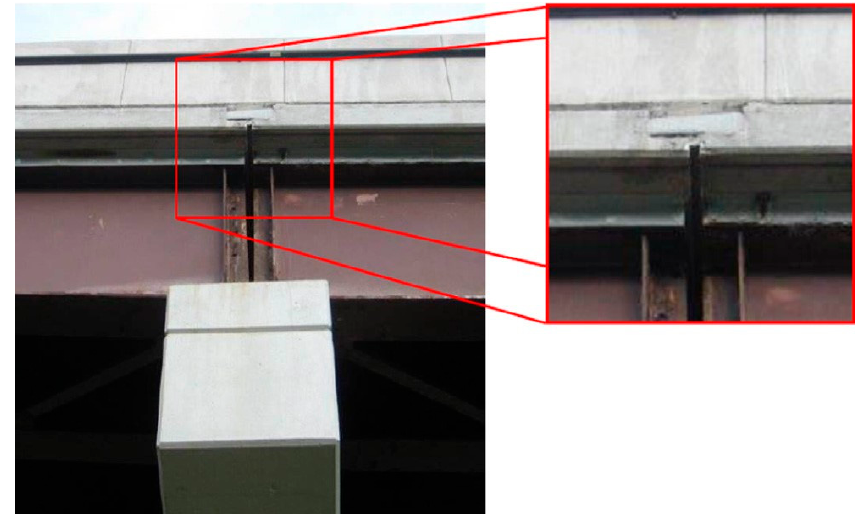
Figure 7. UHPC link slab utilized among girders on BE decks [136] . Figure 7. Elevation image of the UHPC link slab [137].